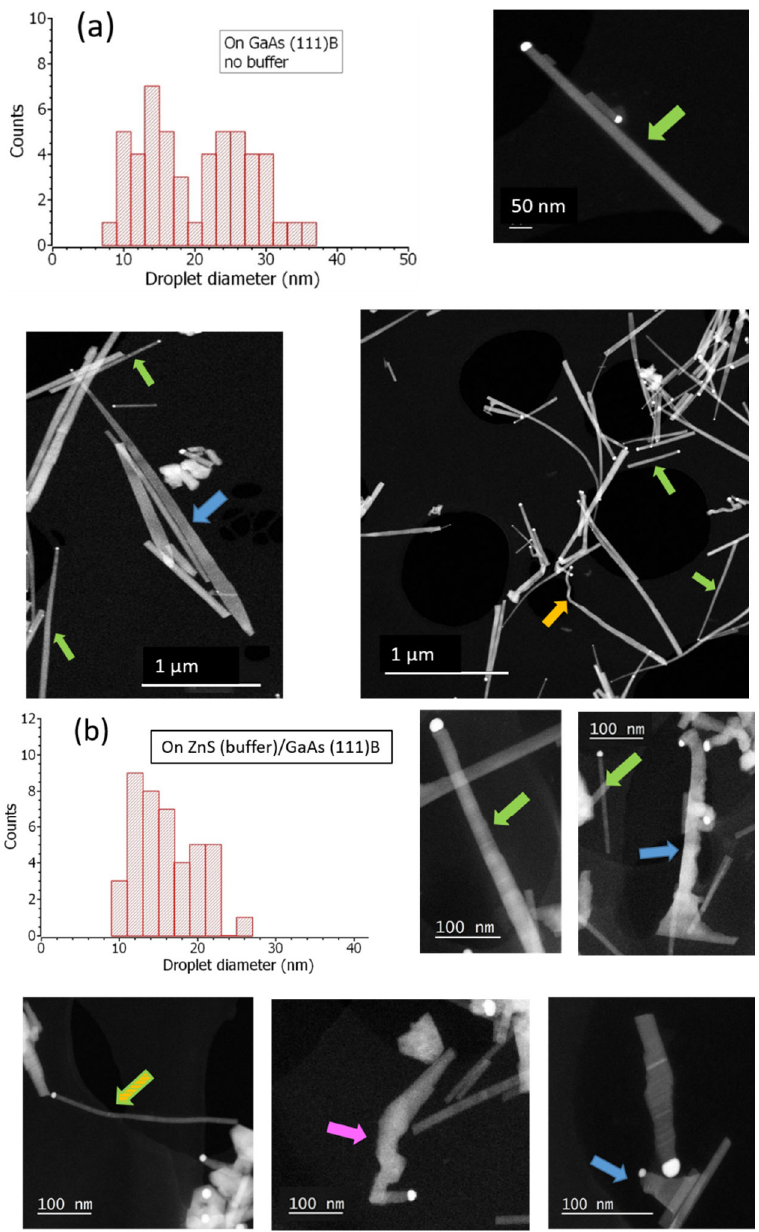
Figure 8. STEM/HAADF image and droplet diameter statistics of ZnS NWs grown on: ( a ) GaAs (111)B, and ( b ) ZnS (buffer)/GaAs (111)B.